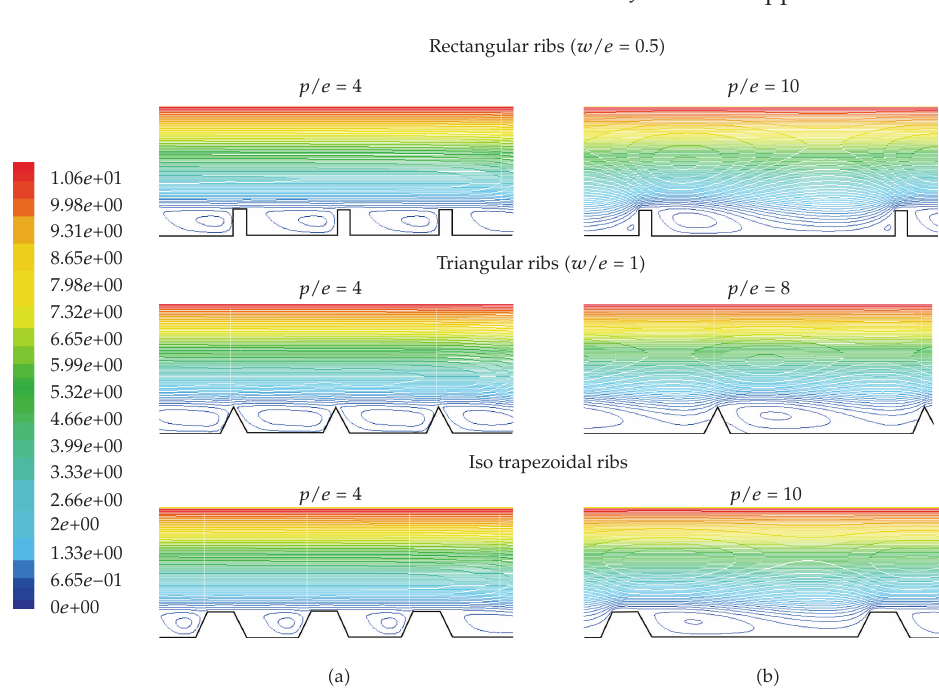
Figure 13: Stream function contours at Re (cid:8) 50000 and di ff erent significant pitches, for square, rectangular (cid:6) w/e (cid:8) 0 . 5 (cid:7) , triangular (cid:6) w/e (cid:8) 1 . 0 (cid:7) and iso trapezoidal ribs, e/d (cid:8) 0 . 05: (cid:6) a (cid:7) d-type behavior and (cid:6) b (cid:7) k-type